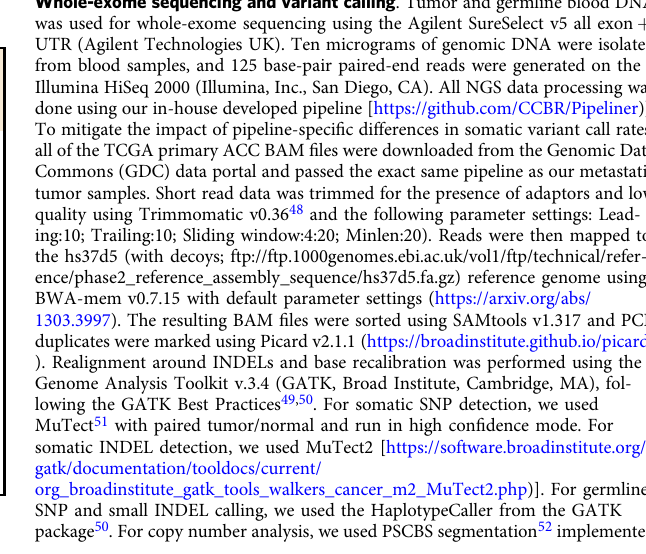
DNA extraction . Total genomic DNA was extracted from freshly frozen tumor tissues using a prep kit from Qiagen. The germline DNA was extracted from blood using a Qiagen Blood DNA Prep kit. All the procedures were done based on manufacturer ’ s recommendations.